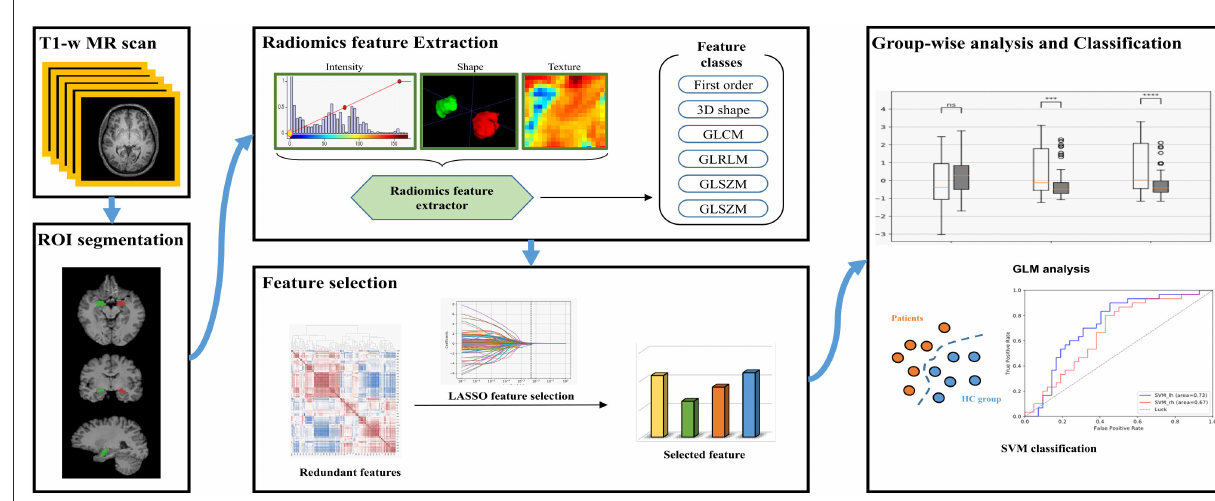
FIGURE1 The workflow of this study.